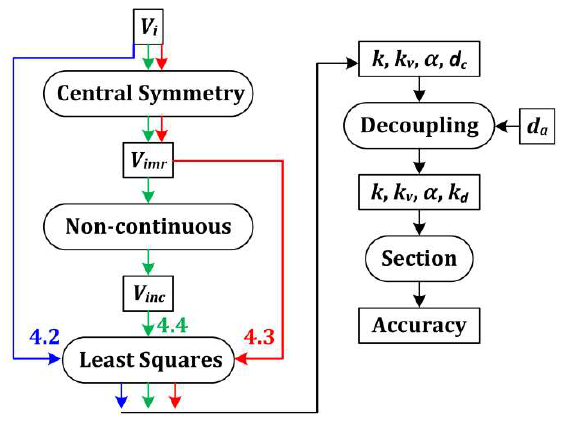
Figure 14. Overview of three types of calibrations.